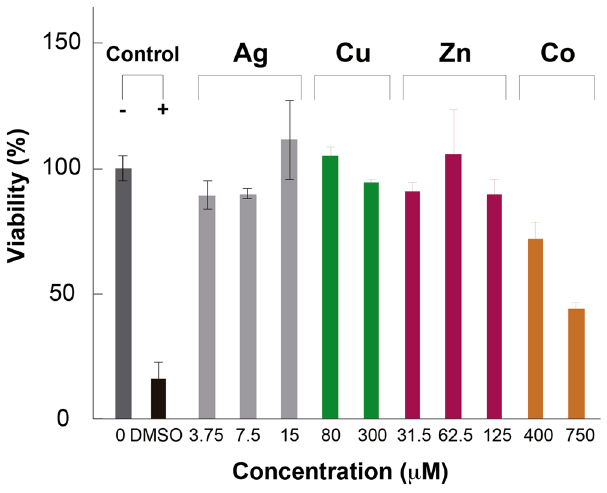
Figure 8. Cytotoxicity of Individual Transition Metals on HaCat cells. Effect of transition metals on the viability of HaCat cells. Cells were treated with individual treatments of transition metals at different concentrations for 24 h and viability was determined. Data are expressed as percent of control mean ± SEM and analyzed by one-